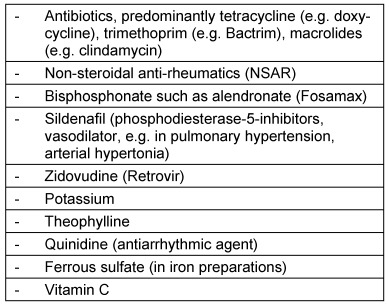
Drugs possibly inducing OMIEI (modified according to [1, 275])